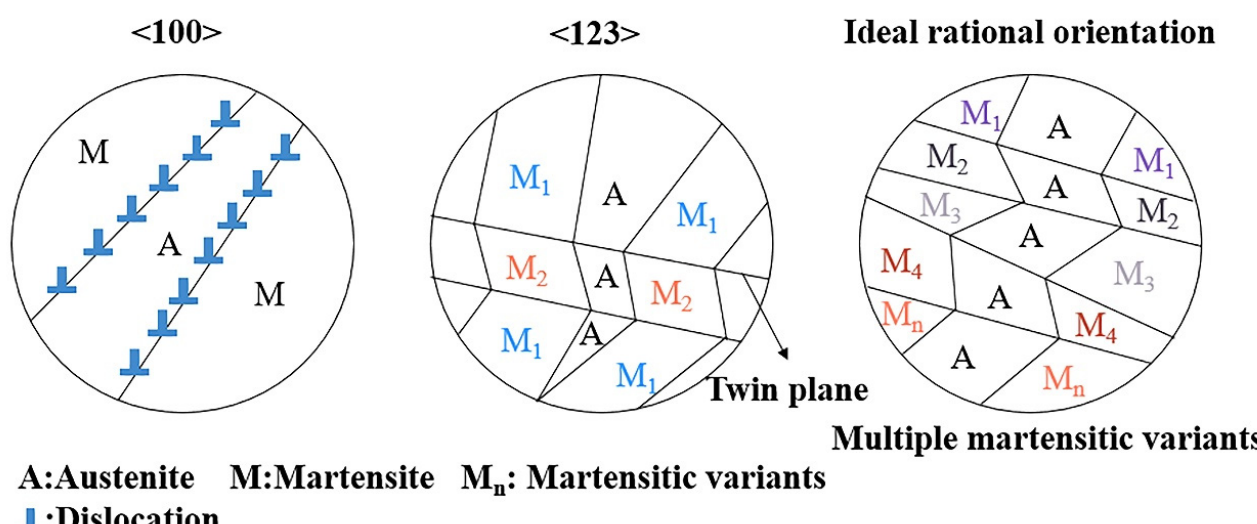
Figure 13. Schematic diagram of the effect of grain orientations on superelasticity.